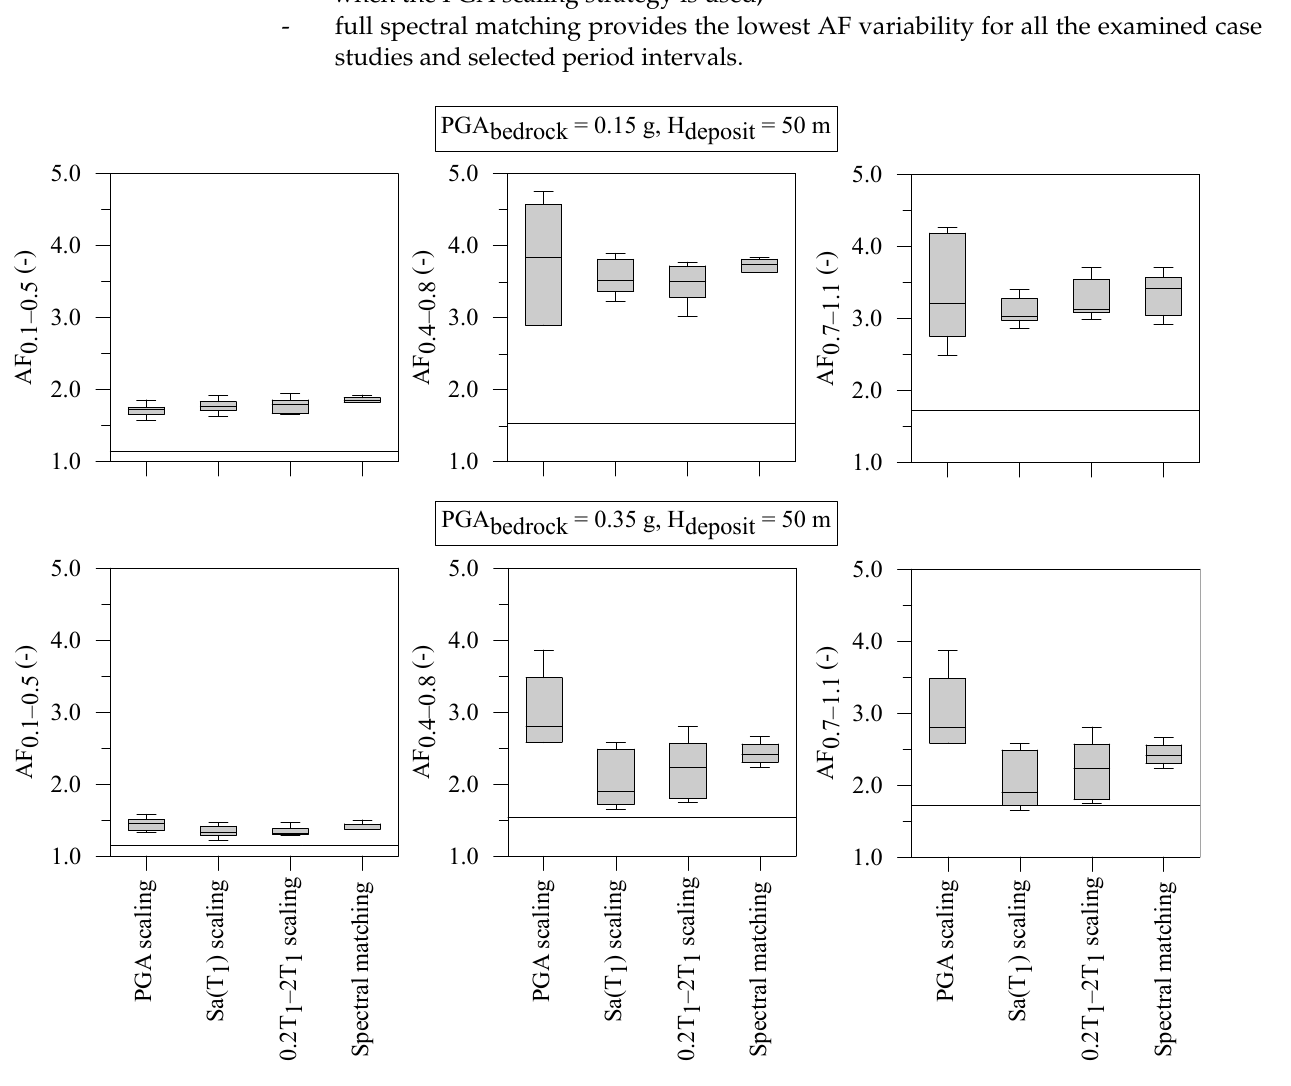
Figure 9. Box plots of AFs for a deposit thickness equal to 50 m and V S1 (z), considering 4 selection strategies for the input motions. The constant value retrieved from EC8 (thin black line) refers to ground type C.